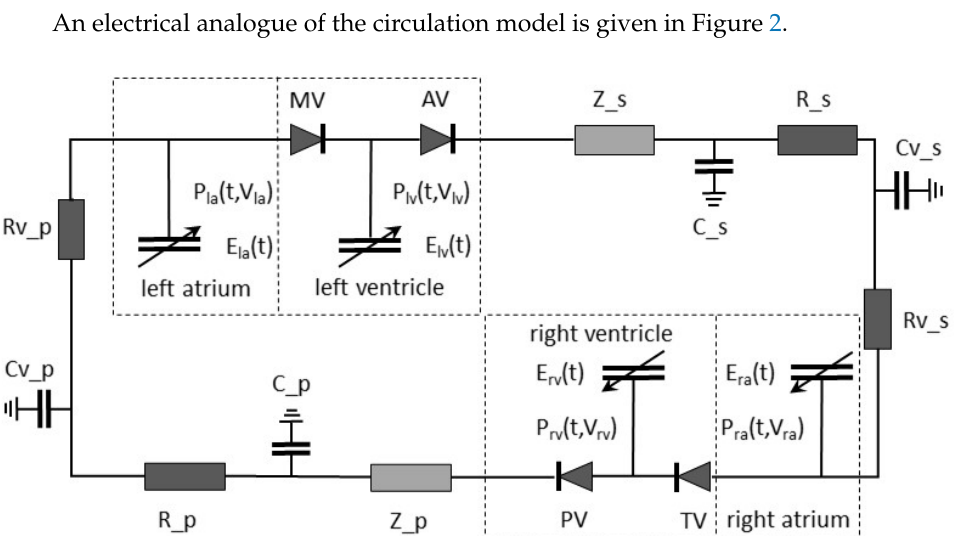
Figure 2. Electrical analogue of the circulation model. The single components are denoted by the following designation. Vascular and specific resistance: R, Z. Vascular compliances: C. Venous system: v. systemic circulatory system: _s. Pulmonary circulatory system: _p. Valves: TV, PV, MV, and AV. Elastance function of the atria and ventricles: E. A closer description of the single components is given in Table S1 in the supplemental